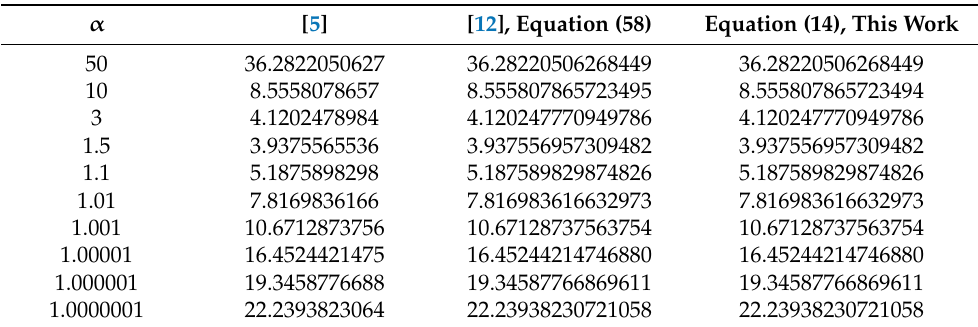
Table 3. Comparison of calculations for the self-inductance (in µ H/m) for values of the shape factor, both close to and far from the singularity α →